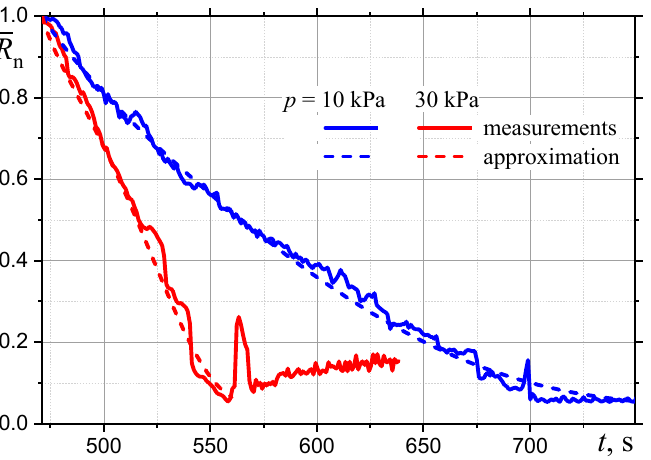
Figure 8. Time dependences of the normal reflectance of the molten copper sample.